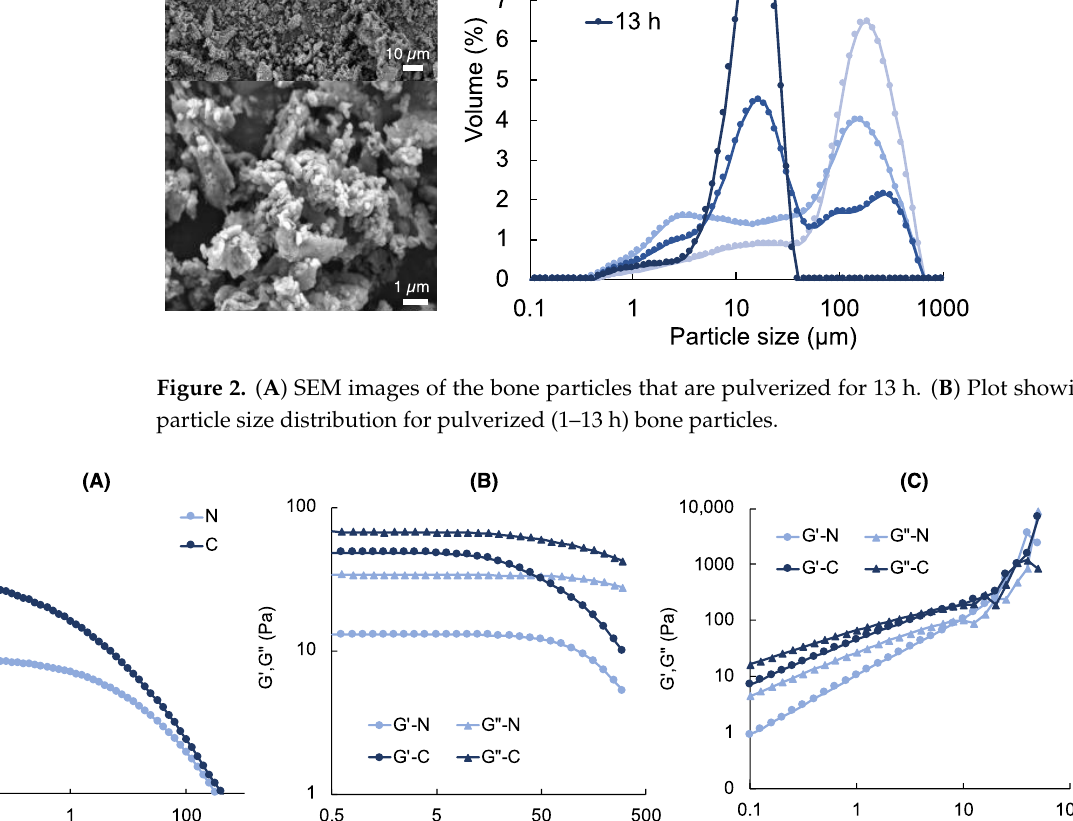
Figure 1. Preparation of composite bioinks. Pictures showing MeALG, bone powder, and composite ink solution in PBS containing photoinitiator (LAP). After addition of hMSCs, composite bioink is transferred into a syringe for bioprinting.